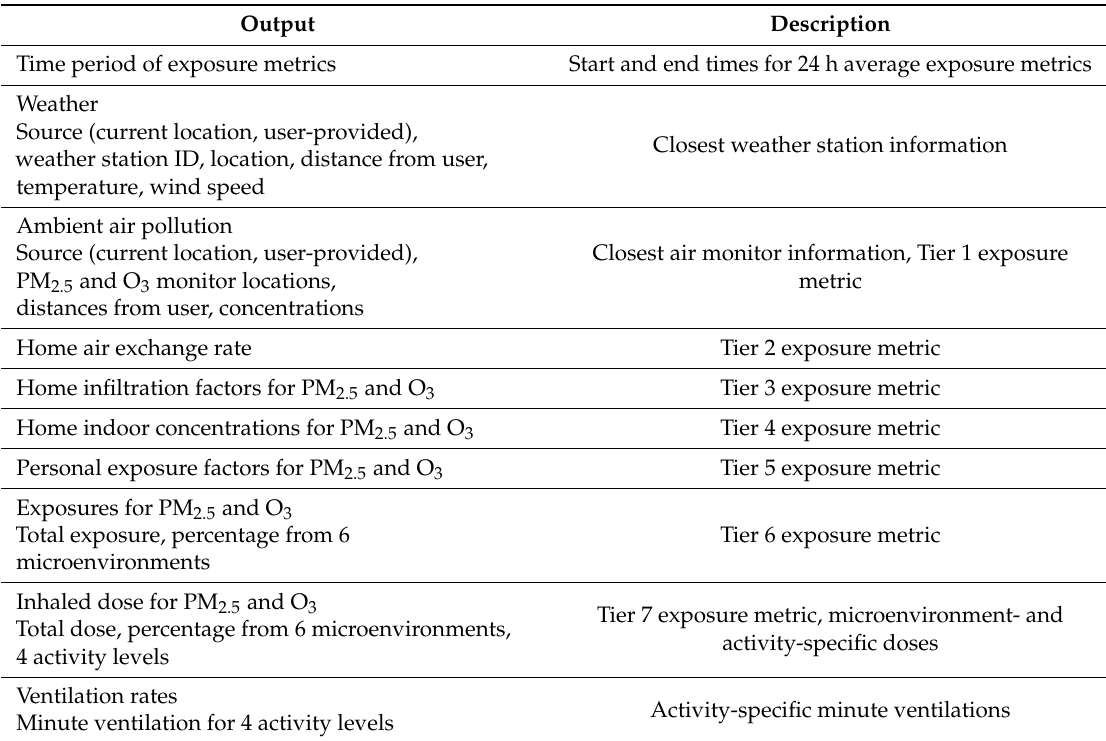
Table 2. TracMyAir